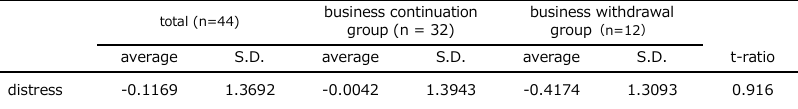
Table 1. t test of